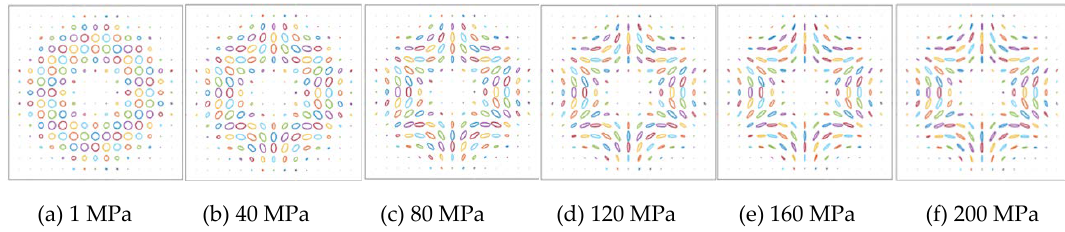
Figure 11 . Phase distribution of HE31 even and odd modes under the stress from 1 MPa to 200 MPa in the y direction. Figure 12. Polarization distribution of HE31 mode under stress from 1MPa to 200 MPa in the y direction.